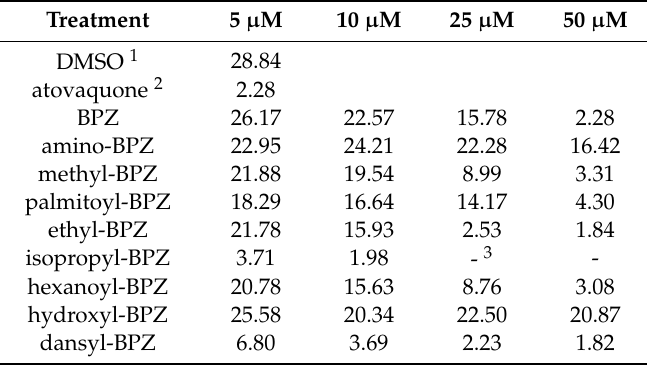
Table 1. Average number of T. gondii tachyzoites per